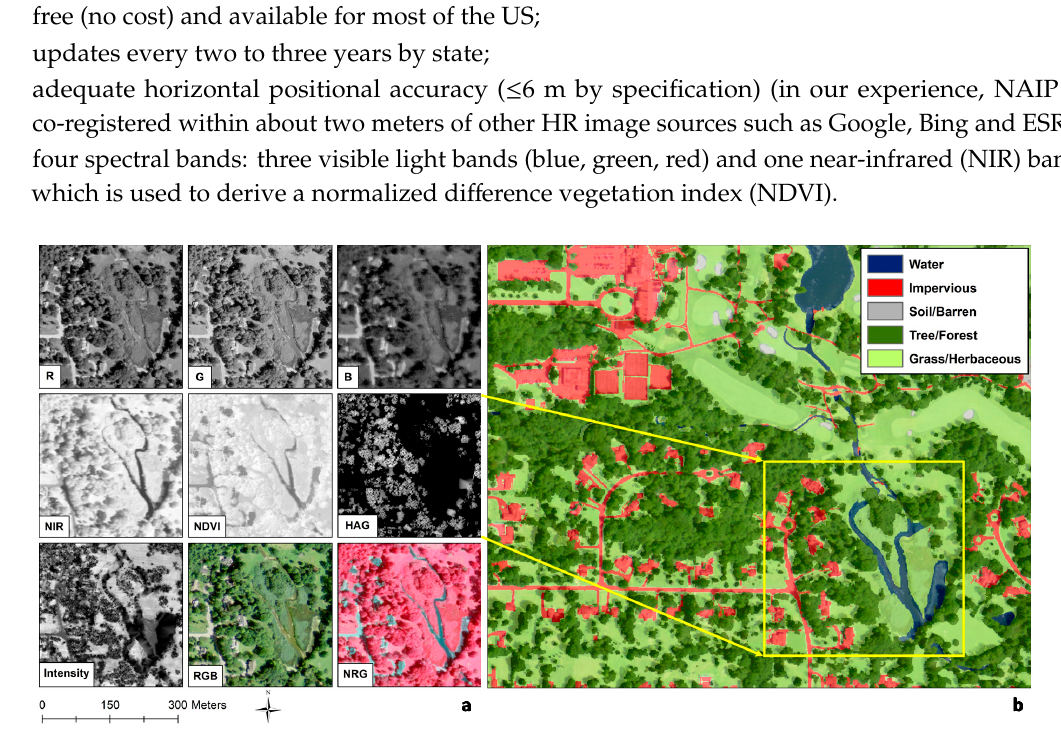
Figure 3. National Agriculture Imagery Program (NAIP) air photo and LiDAR raster band stack used in MULC classification. ( a ) Seven band raster stack typically used in MULC classification, plus RGB and NIR for reference. ( b ) MULC with 50% transparency overlaid on NAIP air photo showing region of zoomed insets in ( a ). R (red), G (green), B (blue), NIR (near infrared), NDVI (normalized difference vegetation index), HAG (LiDAR height above ground), Intensity (LiDAR intensity), RGB (red-green-blue true color), NRG (NIR-red-green false color composite). Note how di ff erent landscape features express di ff erently between spectral